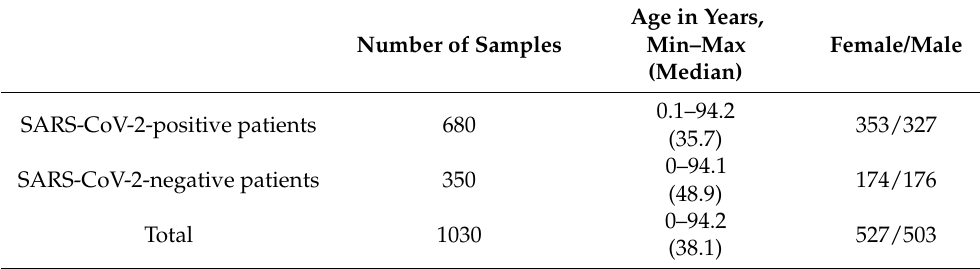
Table 1. Data of patients studied for WU and KI polyomavirus